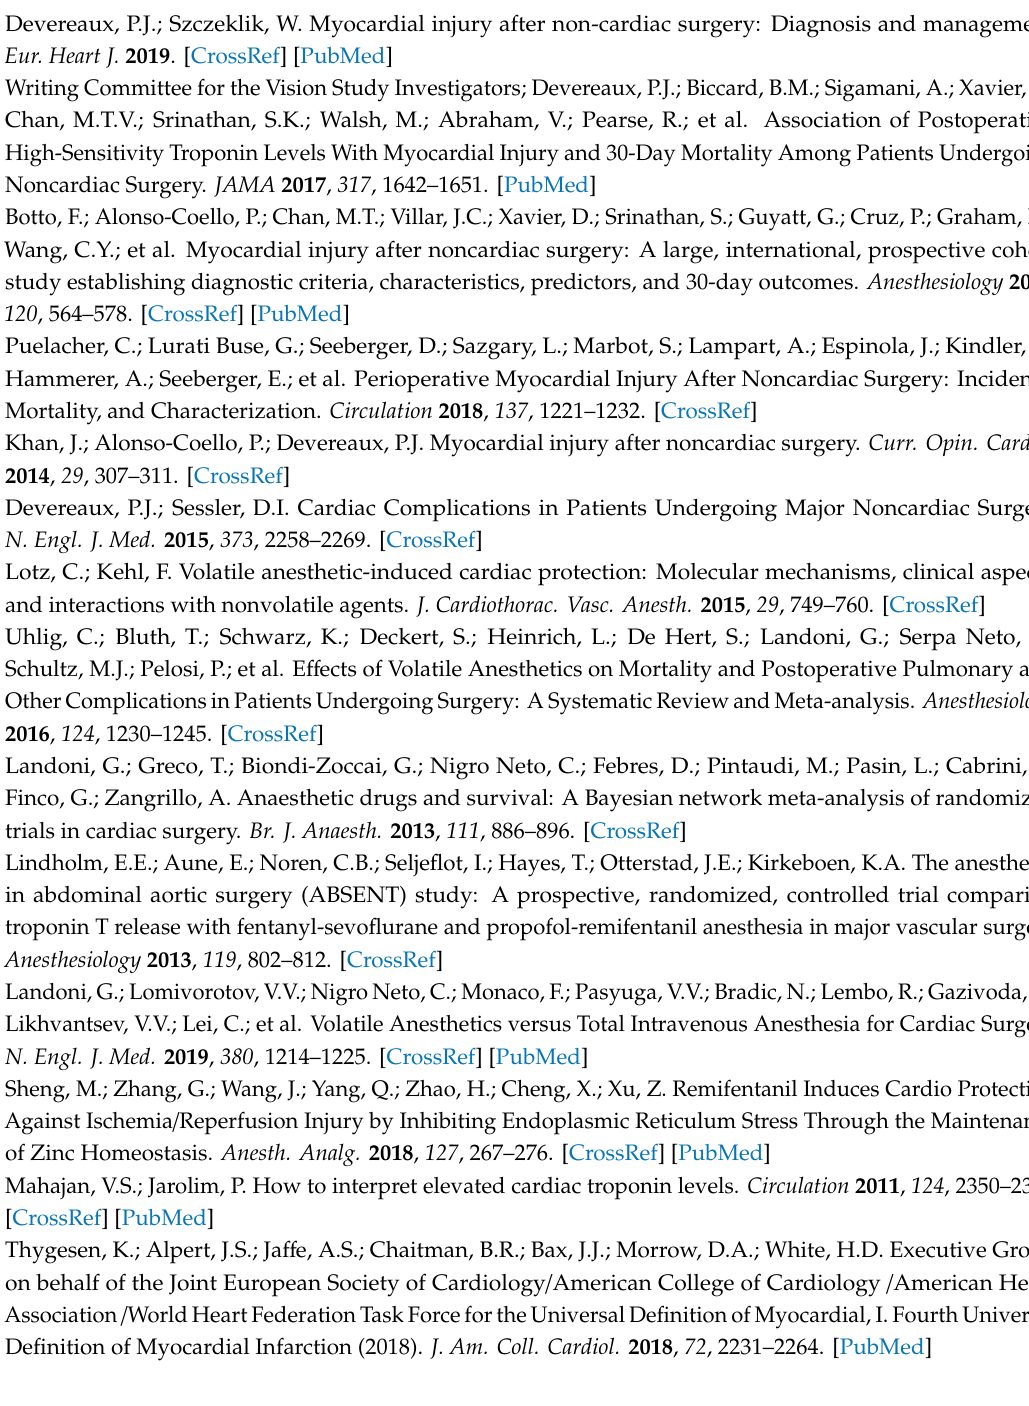
Figure S1. Subgroup analysis for MINS, Figure S2. Subgroup analysis for AKI, Table S1: Operation types according to operative risk in entire population, Table S2: Clinical outcomes comparing volatile anesthetics only group versus Balanced